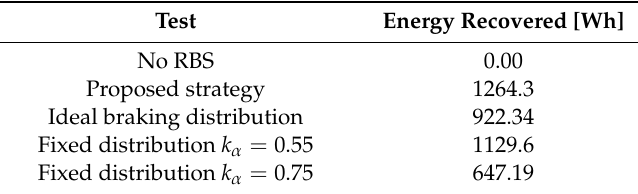
Figure 14. Energy consumption comparison. Table 4. Energy consumption results for endurance test.